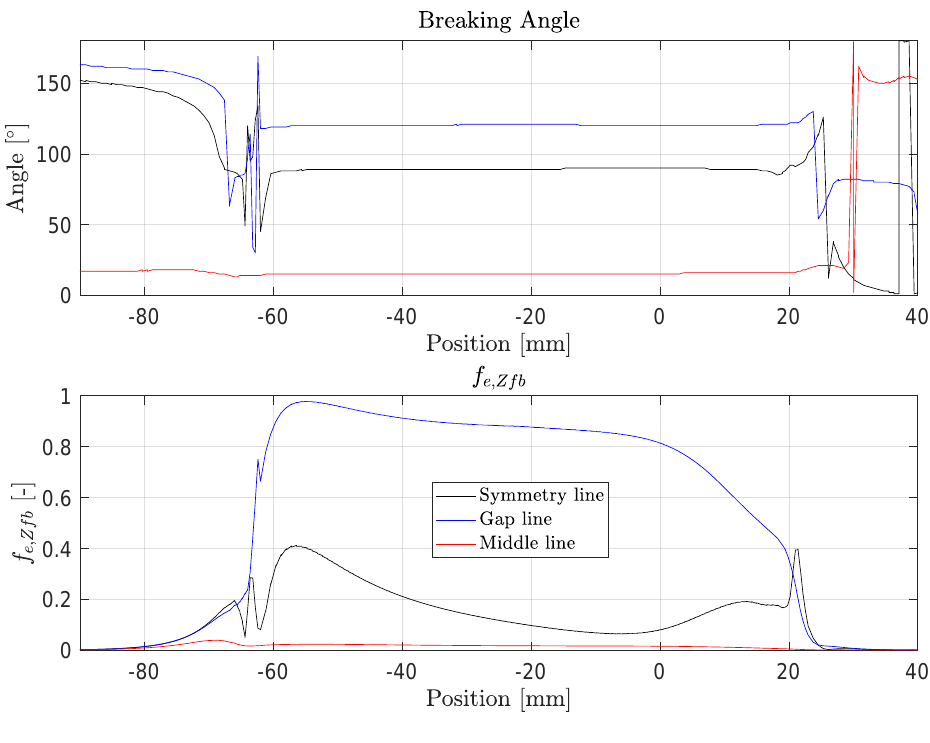
Figure 18. Interfiber fracture exertion and breaking angle at σ = 1856 MPa along the